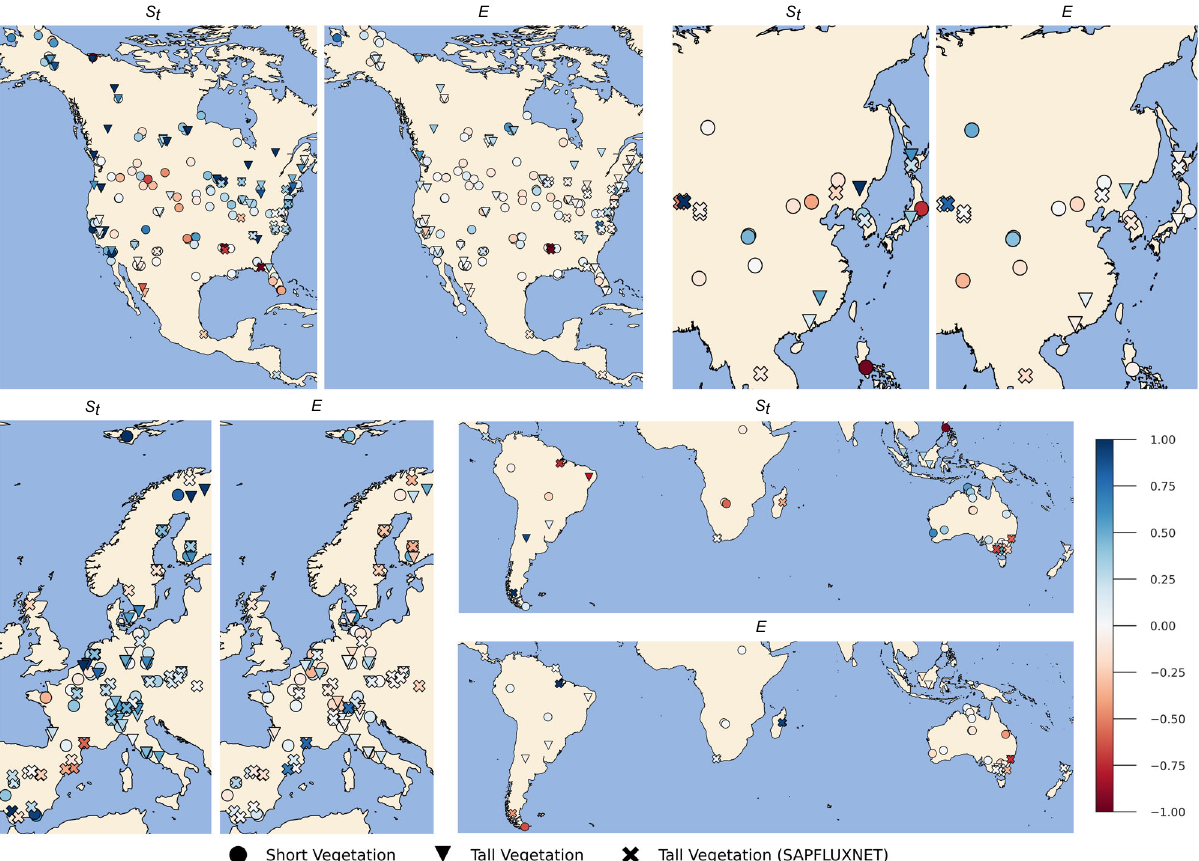
Fig. 3 In situ comparison of the hybrid and process-based models. Maps showing the difference in the Kling-Gupta Ef fi ciency (KGE) metric between the hybrid model and process-based model for the transpiration stress factor ( S t ) and evaporation ( E ) calculated using observations at fl ux tower and sap fl ow measurement sites in different geographical zones: North America (NA), Asia (AS), Europe (EU), Rest of the World (RW). Blue (red) tones indicate an improvement (degradation) in the hybrid model compared to the process-based counterpart. For the sap fl ow sites, transpiration estimates ( E t ) instead of E are